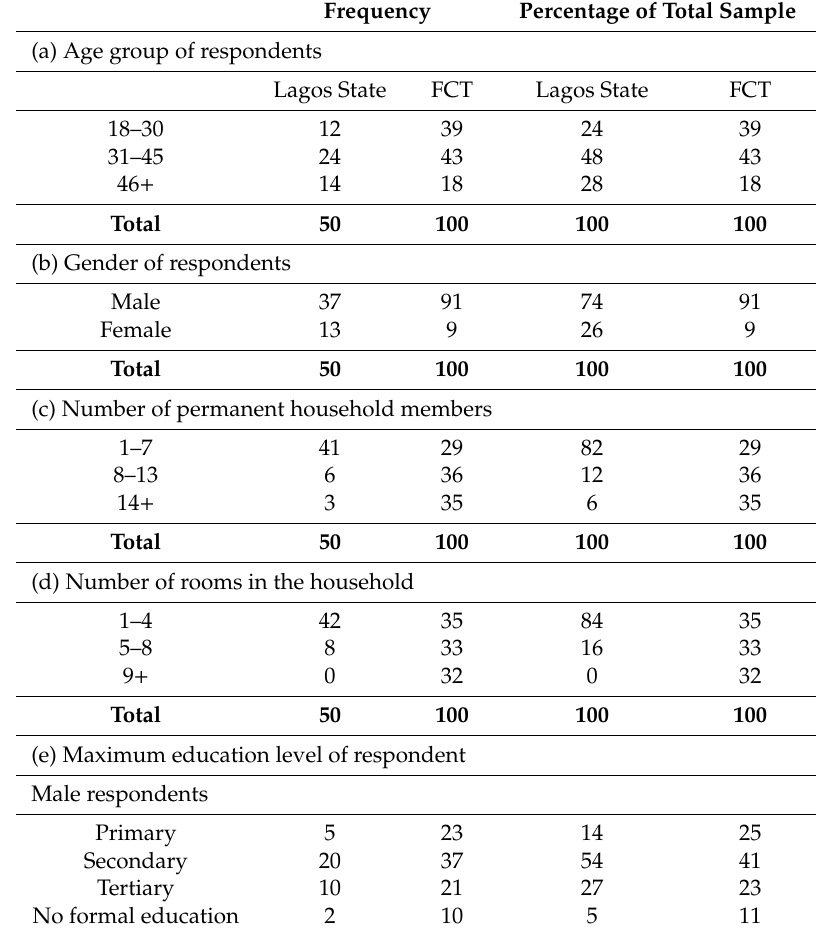
Table 2. Sample description in terms of age, gender, number of rooms in the house, size of household and